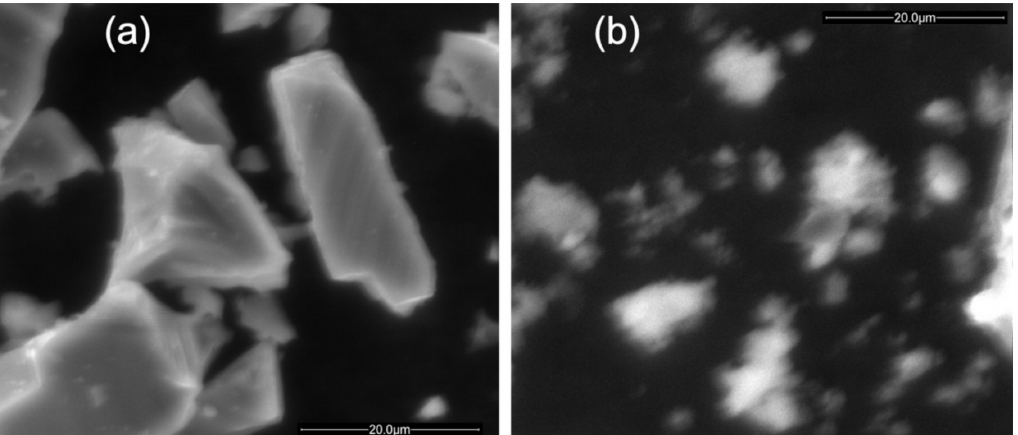
Figure 1. ( a ) An SEM micrograph of the starting material, which was unetched, washed with metallurgical grade Si powder. ( b ) Si particles after etching and grinding without arginine.